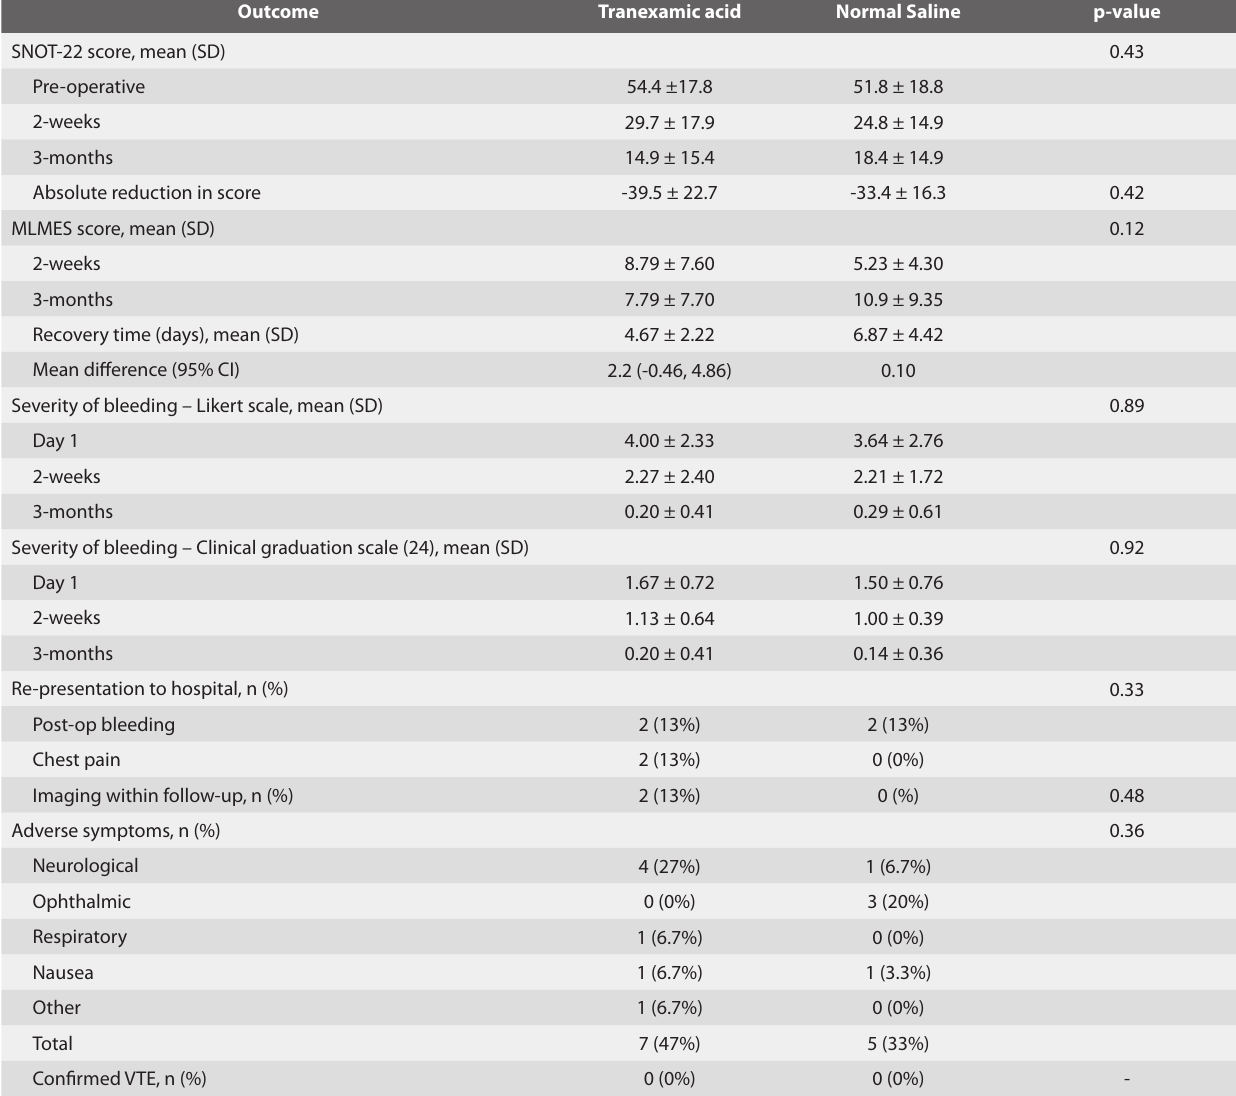
Table 2. Patient